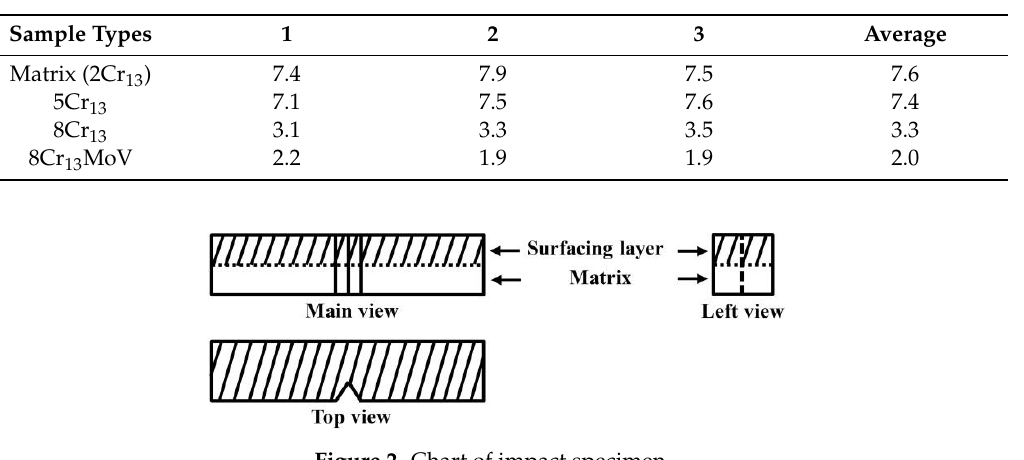
Table 5. Wear weight loss of matrix and the different surfacing layer (mg).